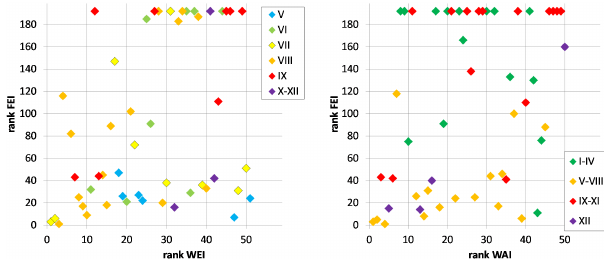
Figure 12. Relationship between rankings of 50 maximum EPEs (left)/APEs (right) and rankings of subsequent floods in various months (distinguished by colors). Precipitation events, whose hy- drological response was too small (no peak flow with return period at least 5 years), are depicted at the top of the